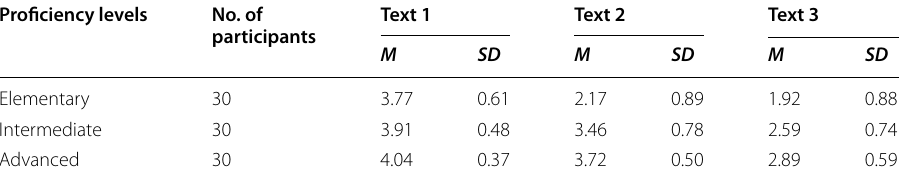
Table 9 Summary of overall reading scores Proficiency